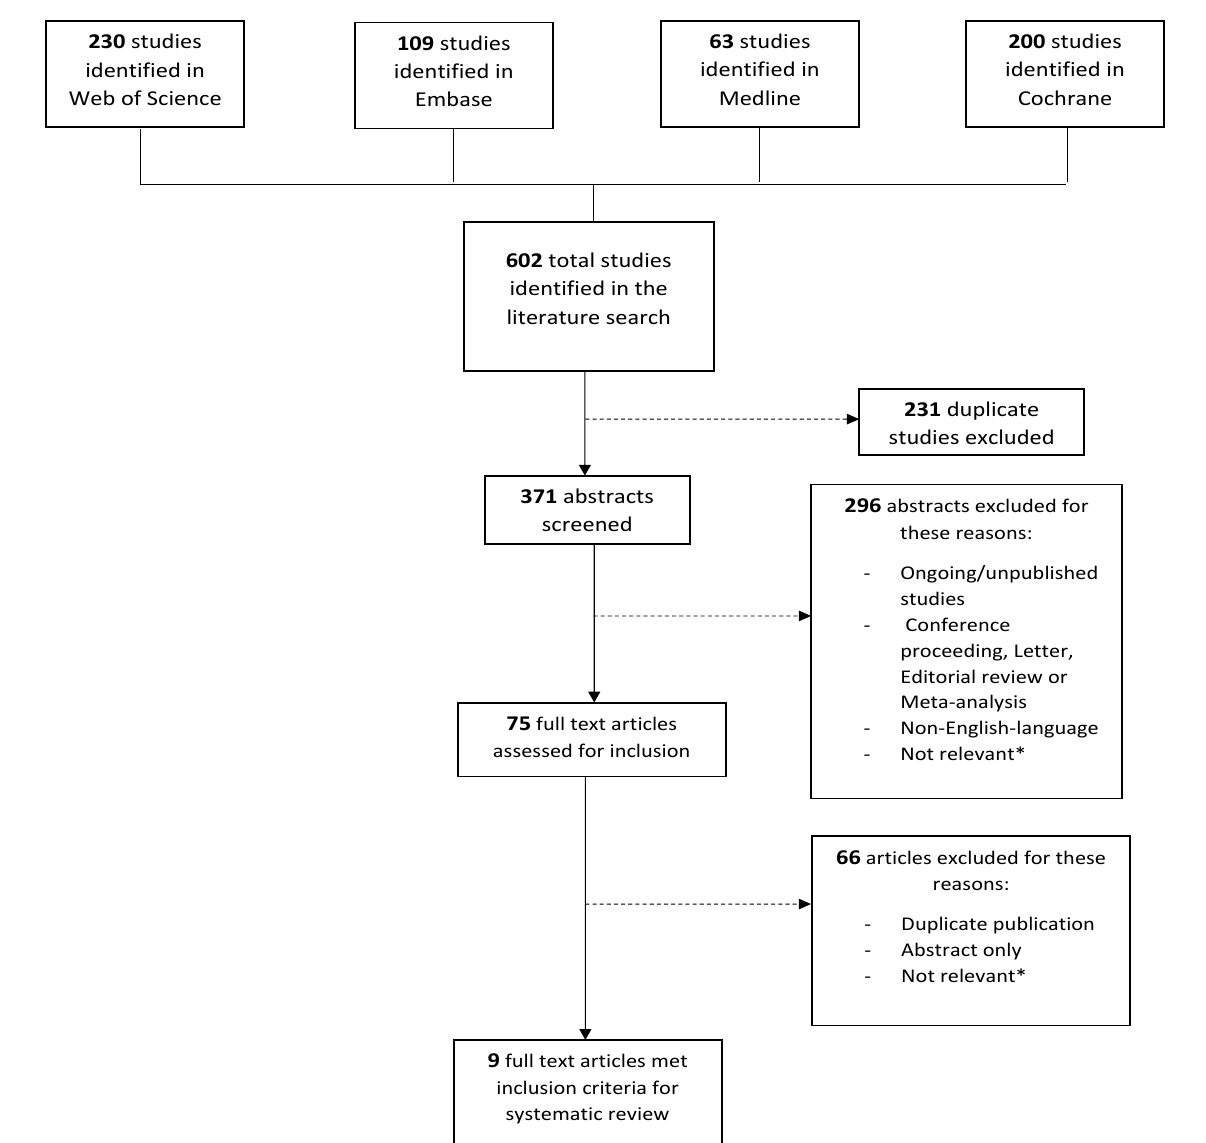
Figure 1. Attrition Diagram of Systematic